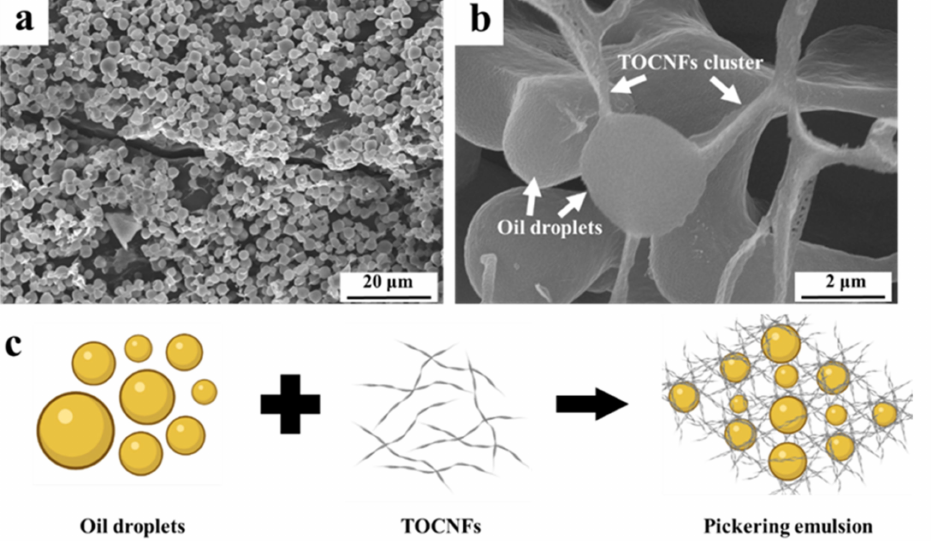
Figure 7. SEM of Pickering emulsions stabilized with TOCNFs ( a , b ); schematic diagram of Pickering emulsions stabilized with TOCNFs ( c